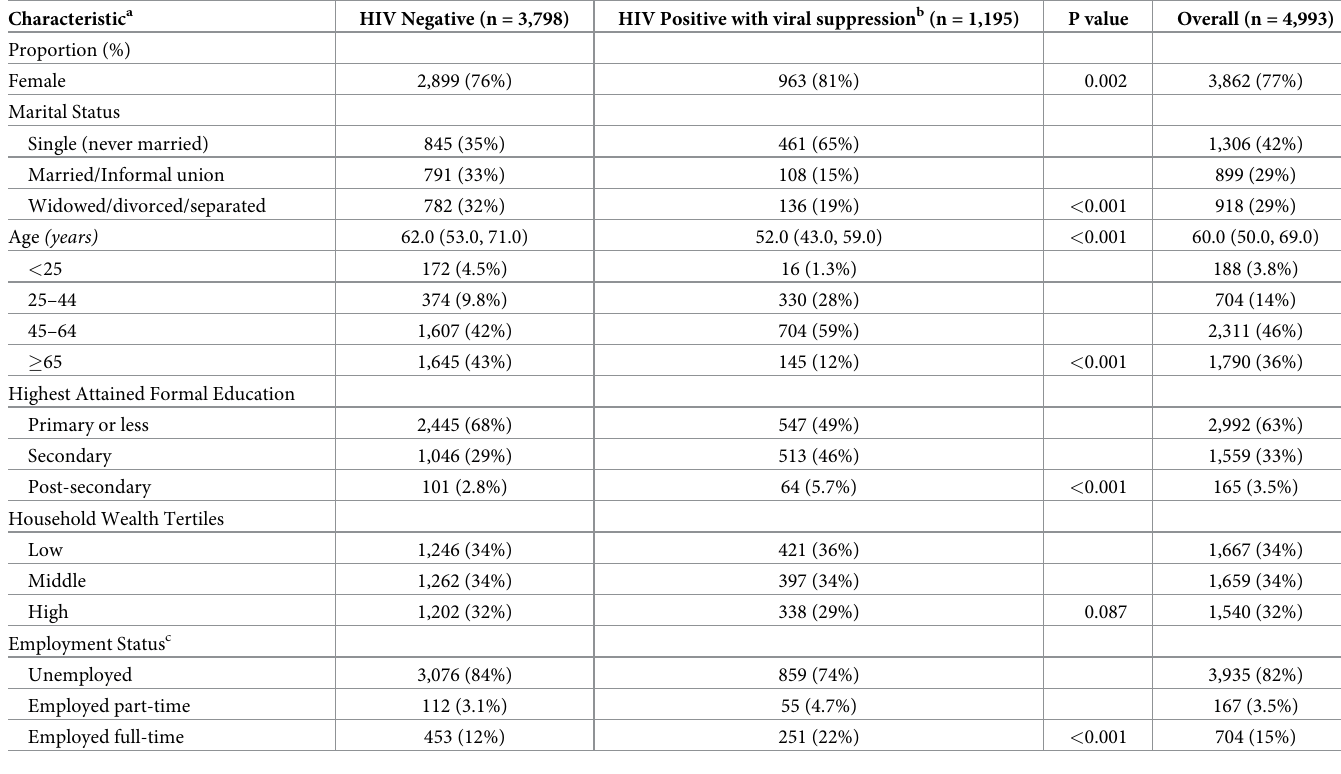
Table 1. Unweighted population characteristics of HIV negative versus HIV positive/successful ART adults with hypertension and/or diabetes mellitus in uMkha- nyakude, KwaZulu-Natal, South Africa. Characteristic a HIV Negative (n = 3,798) HIV Positive with viral suppression b (n = 1,195) P value Overall (n = 4,993) 2,899